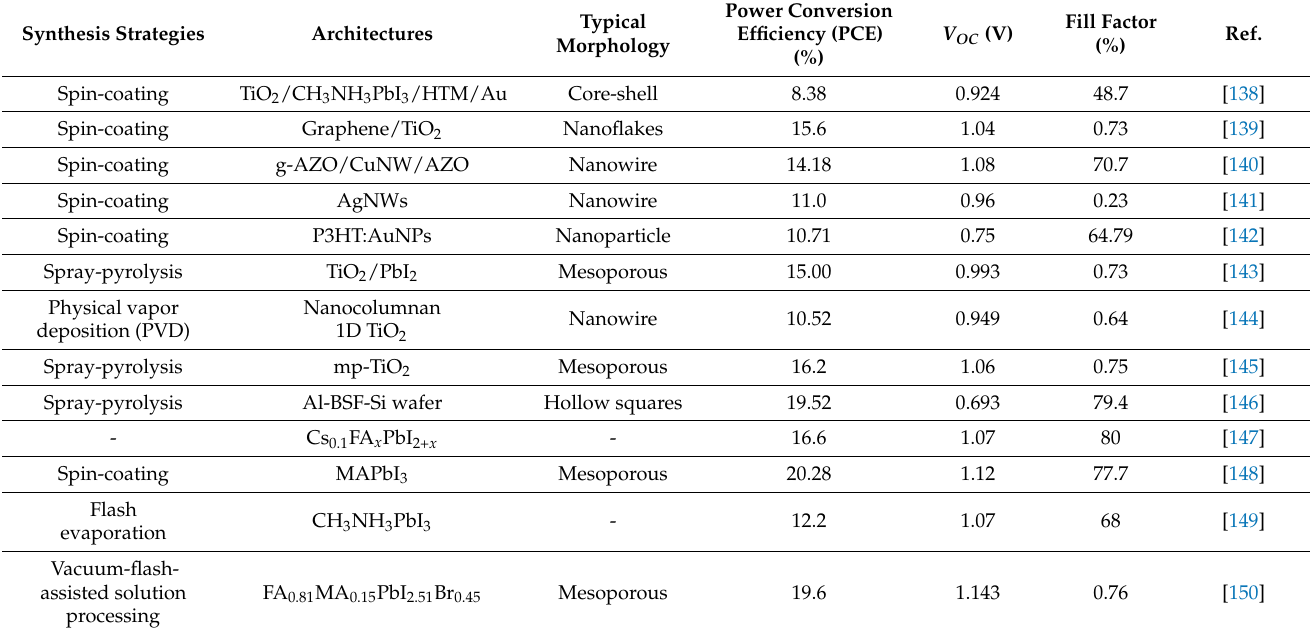
Table 5. Photovoltaic characteristics of different electrode